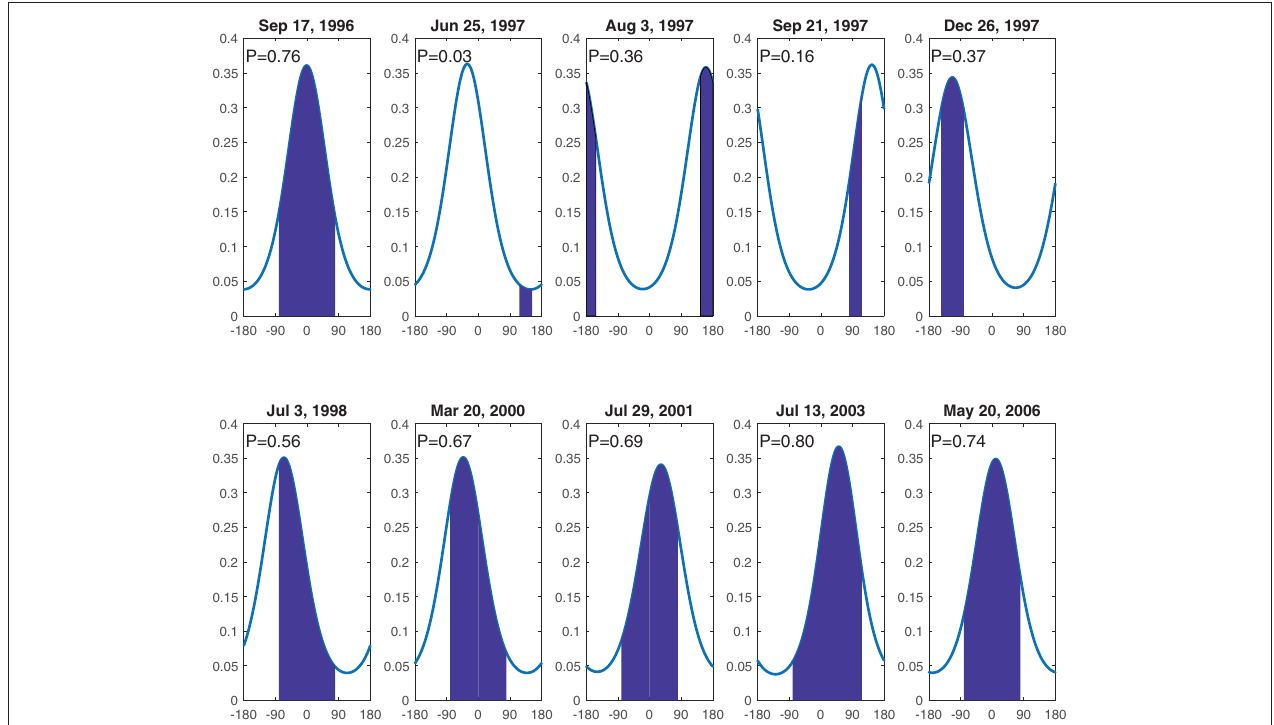
φ j . Area of solid colored band represents the probability (also indicated in { }